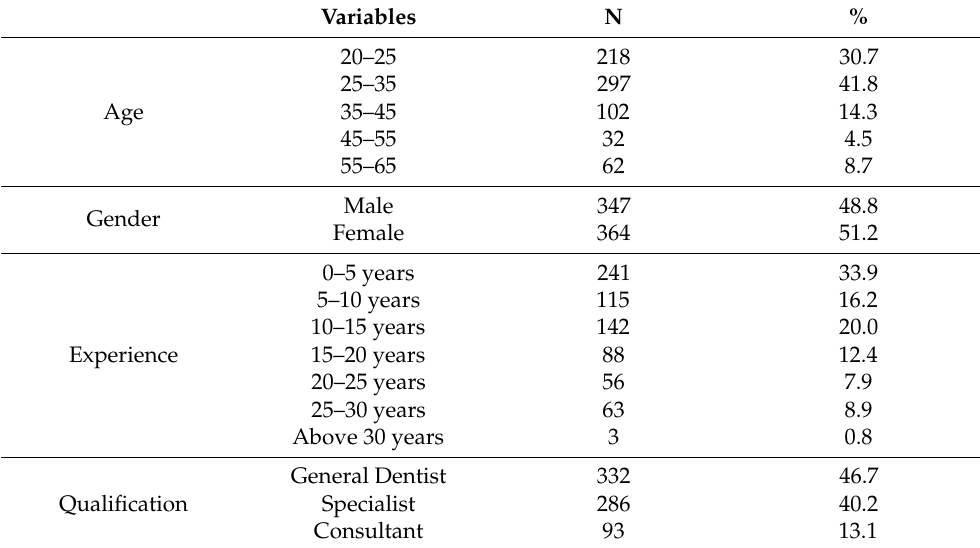
Table 4. Demographic characteristics of the dentists (n =